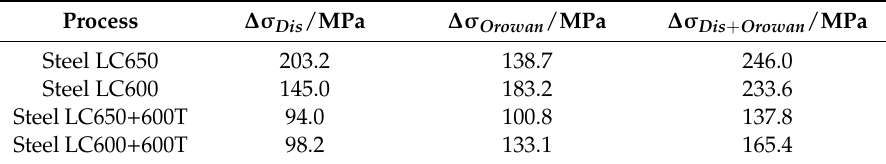
Table 5. Precipitation strengthening and dislocation strengthening contributions at room temperature and elevated